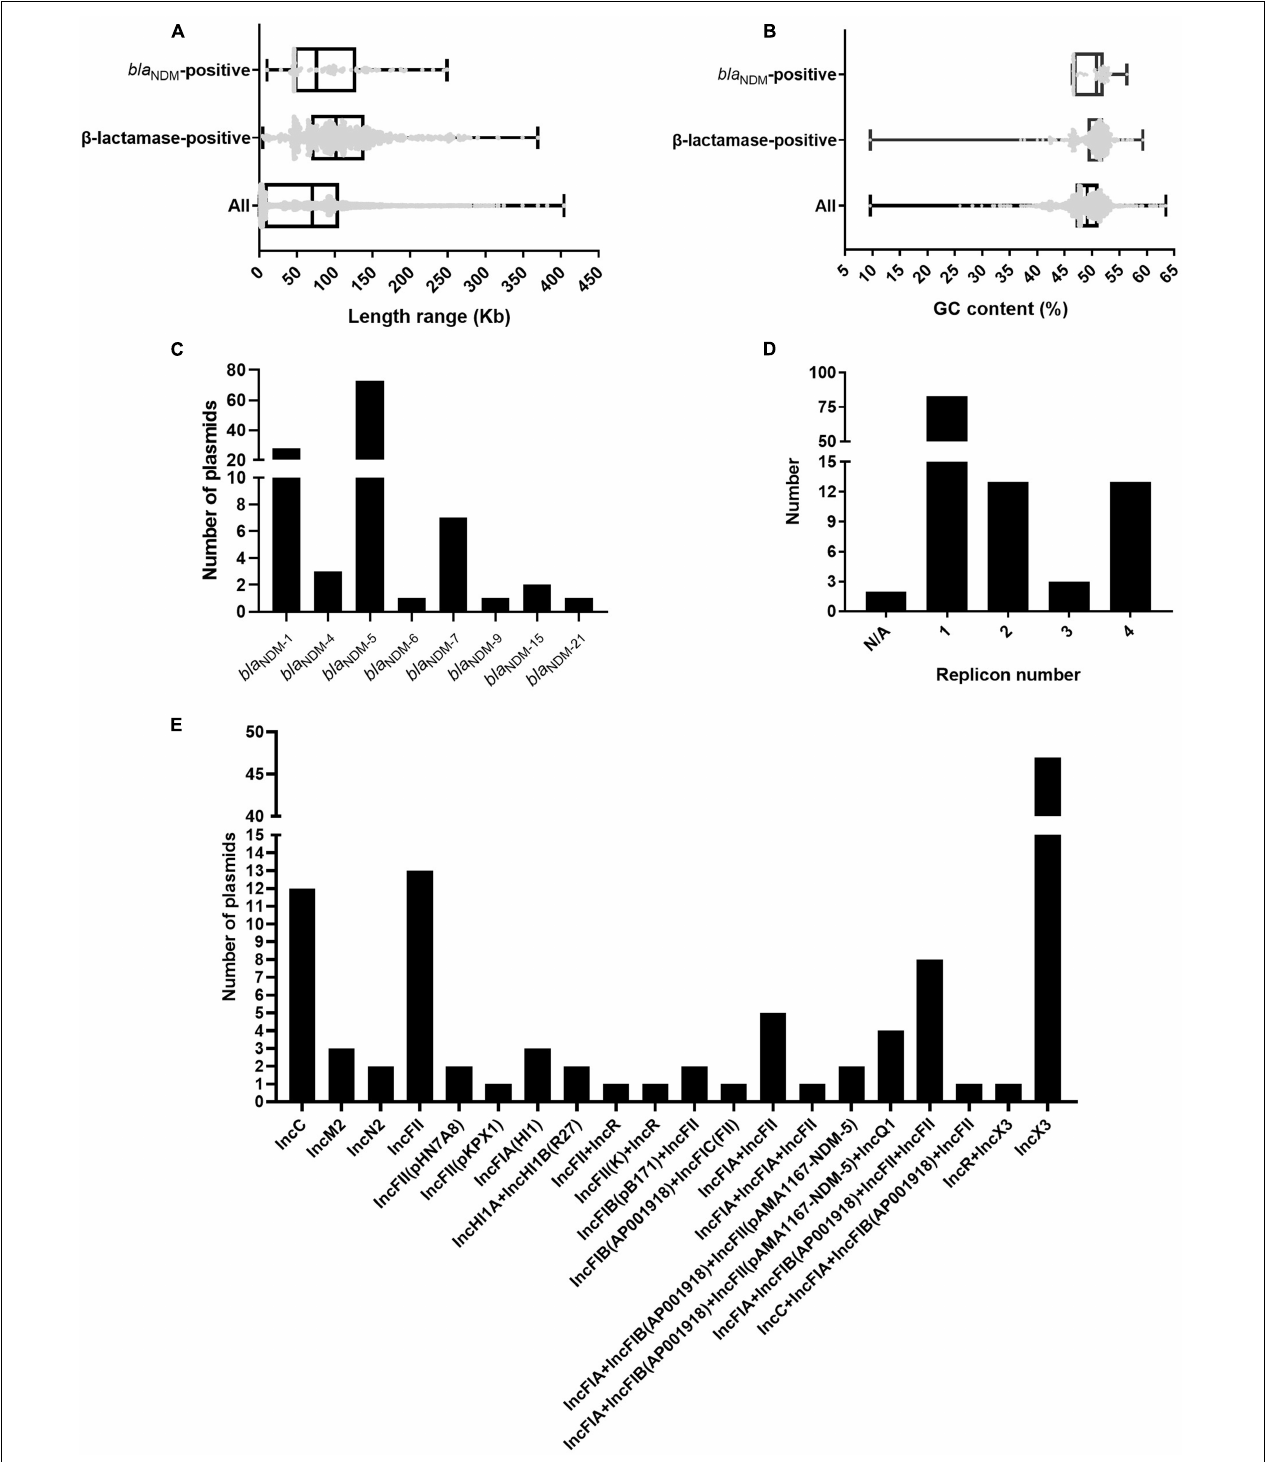
FIGURE 1 | Characteristics of the 114 bla NDM -positive plasmids from 113 completely sequenced E. coli genomes. (A) Box plot of the length distribution of the 114 bla NDM -positive plasmids, the 1001 plasmids carrying β -lactamase genes, and all 3786 plasmids of E. coli . (B) Box plot of the GC content distribution of the 114 bla NDM -positive plasmids, the 1001 plasmids carrying β -lactamase genes, and all 3786 plasmids of E. coli . (C) Histogram of number of variants of bla NDM genes among the 114 bla NDM -positive plasmids. (D) Histogram of number of replicons per plasmid for the 114 bla NDM -positive plasmids. (E) Histogram of number of combination modes of different replicons among the 114 bla NDM -positive